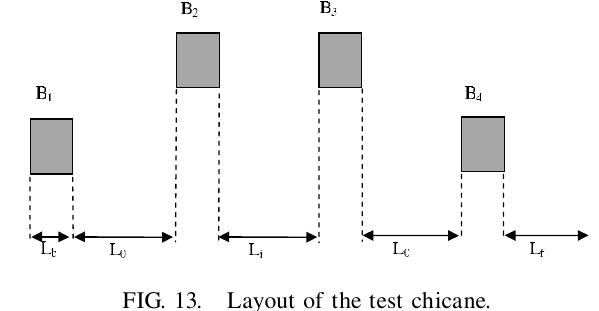
FIG. 13. Layout of the test chicane.